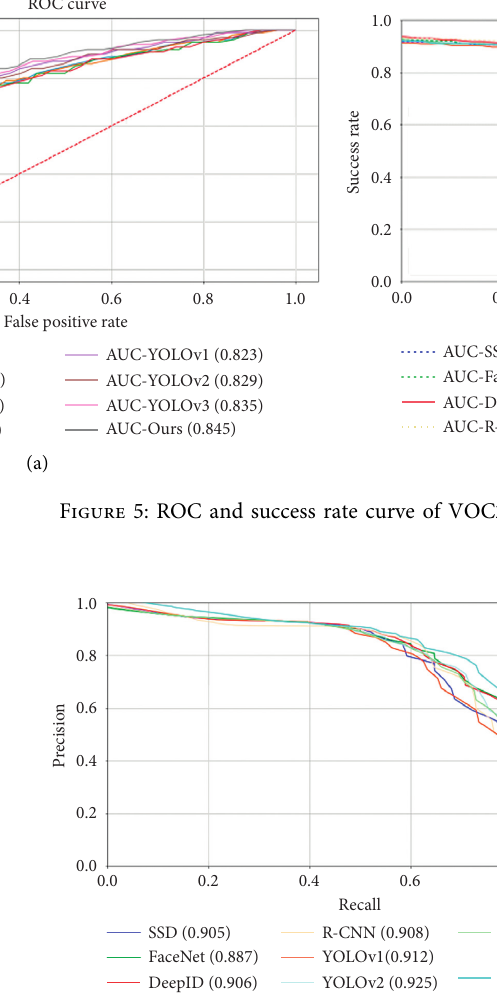
Figure 6: Recall curve of VOC2012 data